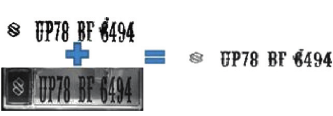
Figure 17: Cropped and inverted binary mask overlapped with the original number plate.